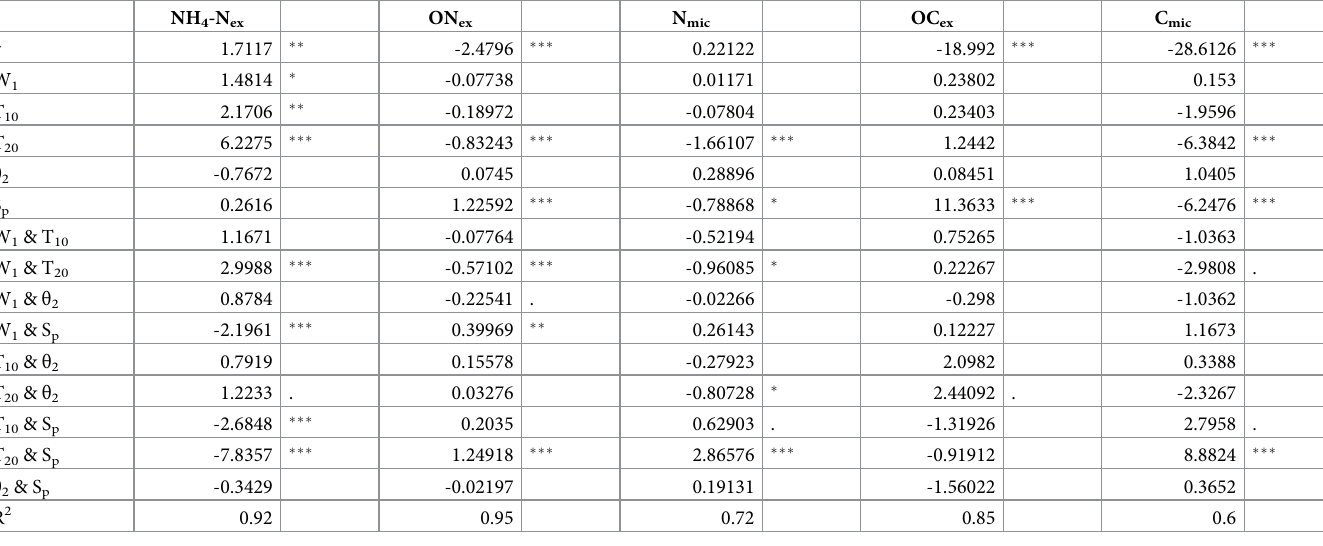
Table 5. Change rate ( μ g g -1 day -1 ) in microbial and extractable N and C pools during the incubation calculated using mixed random effect models (Eq 2). Parame- ter γ represents the change rate for mor (S m ), no worms (W 0 ), lower moisture status ( θ 1 ) at 5˚C temperature (T 5 ). The other treatment effects and the interaction effects (from W 1 to T 20 & S p ) are expressed as a difference with respect to γ